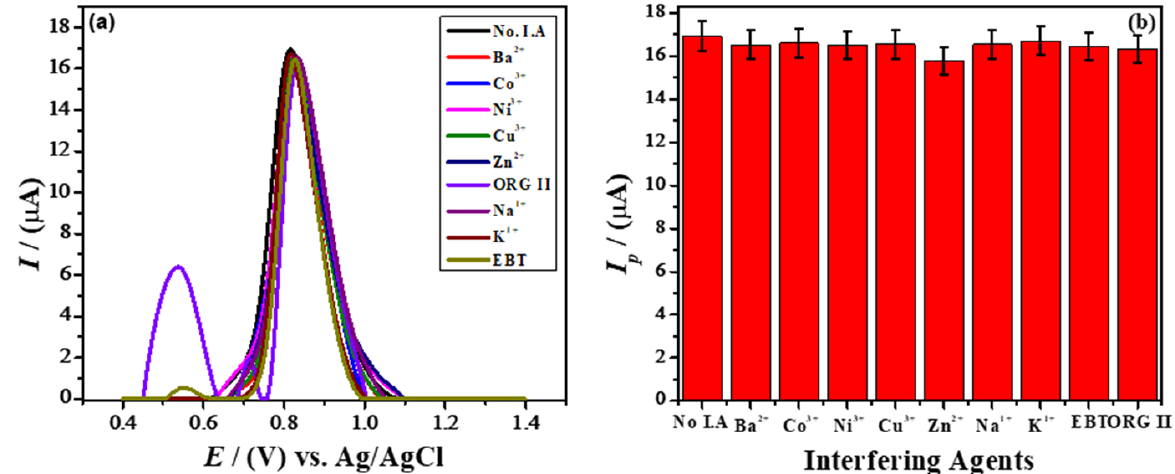
Figure 7. ( a ) SWVs of 10 μM NBS in the presence of different interfering agents using COOH- f MWCNTs/GCE. ( b ) Bar graph of the peak current of NBS at the designed sensor in the presence of interfering species.